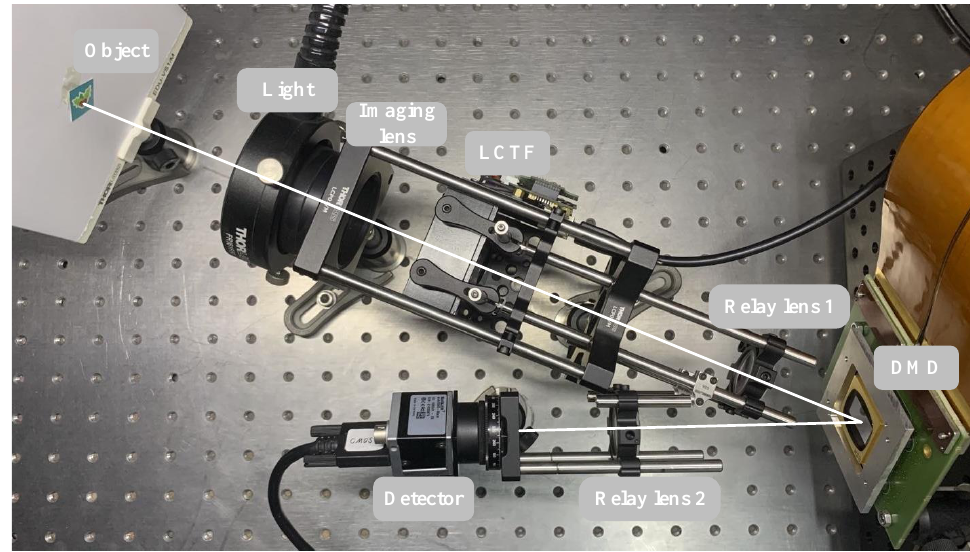
Figure 9. Testbed of the CATF spectral imager.